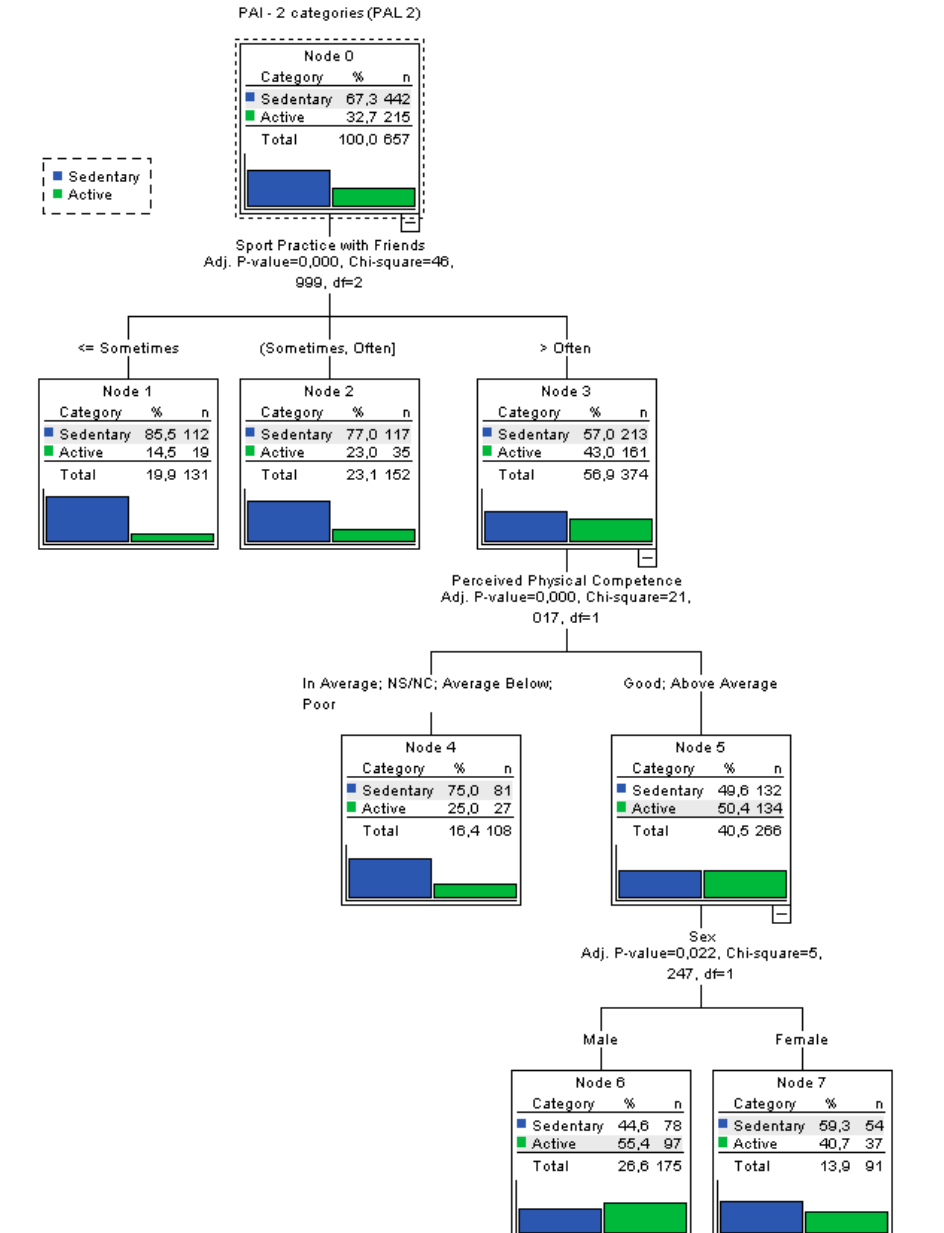
Figure 3. Classification tree for the variable PAL2.